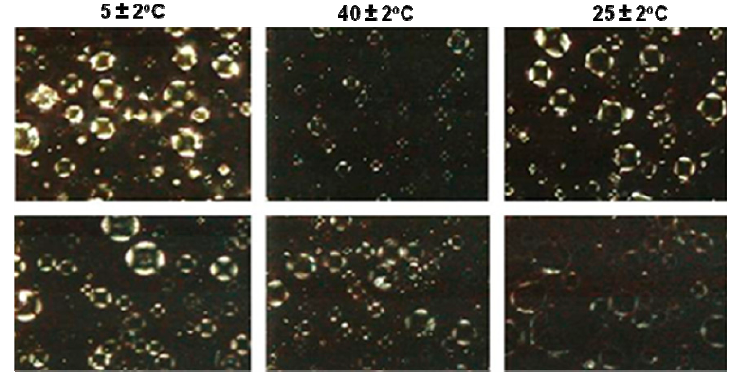
Figure 4. Polarized light photomicrograph (200×) of formula 6.5 after 24 h and 90 days under various storage conditions.